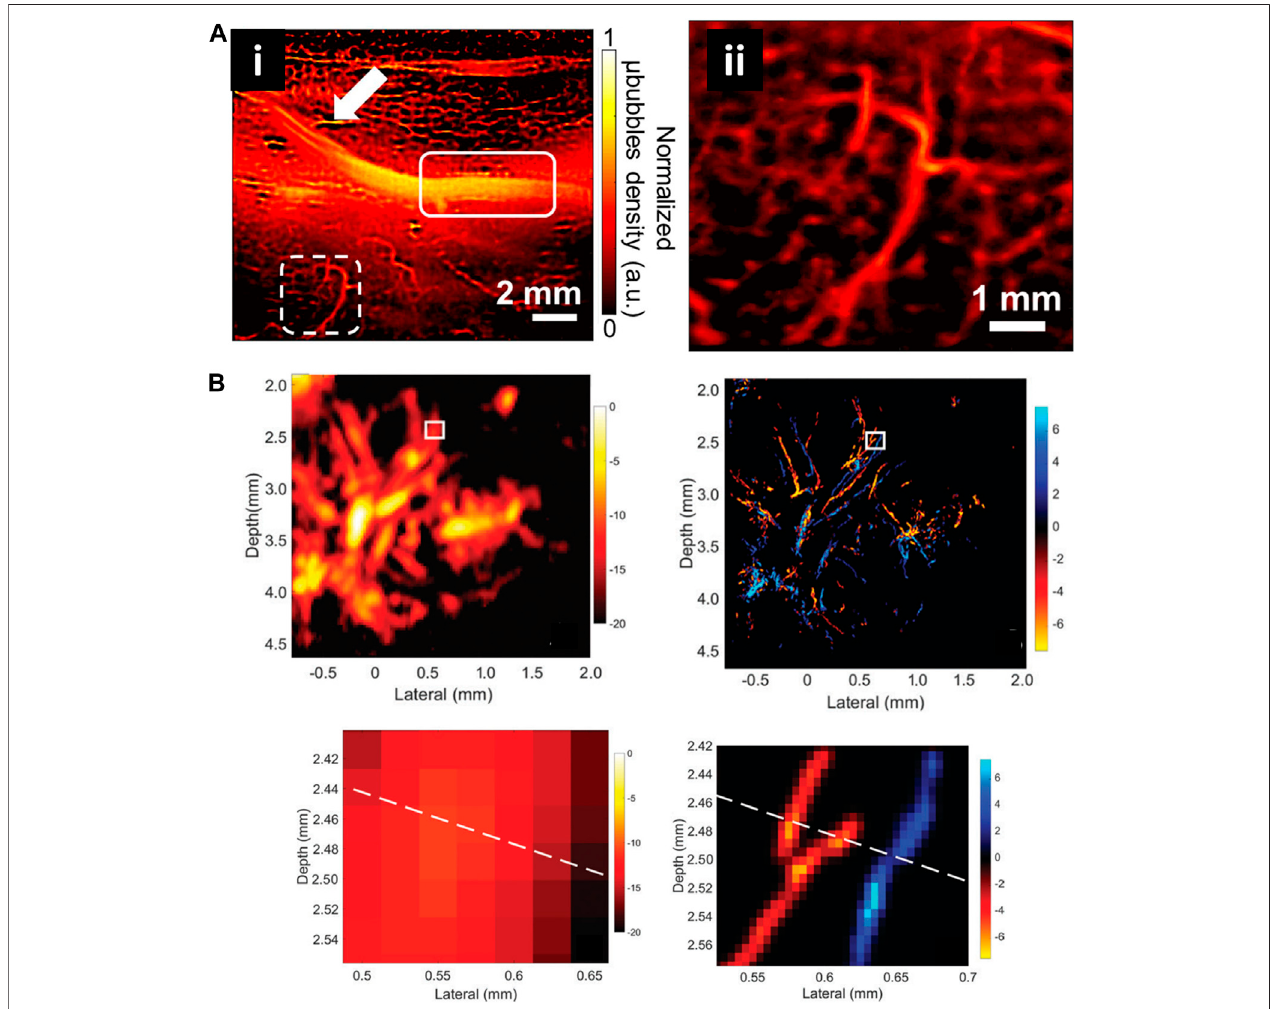
FIGURE 10 | Super-resolved vessel maps by ultrasound localization microscopy. (A) The super-resolution ultrasound image of vascular based on Verasonics system (i) and enlarged view of white dashed rectangle (ii) (Yu et al., 2018). Reprinted from Yu et al. (2018) with permission from Springer Nature. (B) Acoustic subaperture processing (ASAP)-enhancedpower doppler imageand ultrasoundsuper-resolutionimage (Zhu etal.,2019).Magni fi edviewsshowed thedetails ofboxed region. Reprinted from Zhu et al. (2019) Radiological Society of North America.